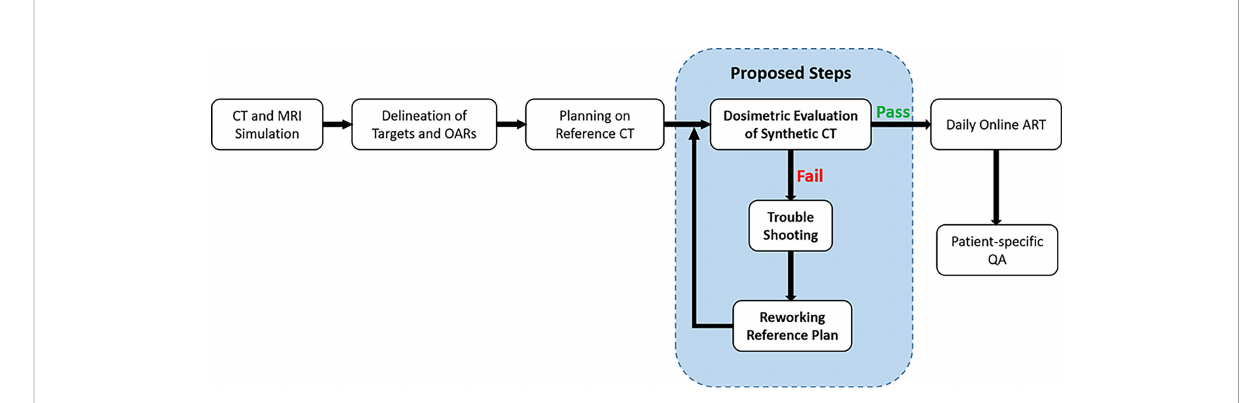
FIGURE 1 Clinical work fl ow integrated with quality control on dosimetric accuracy of synthetic CT